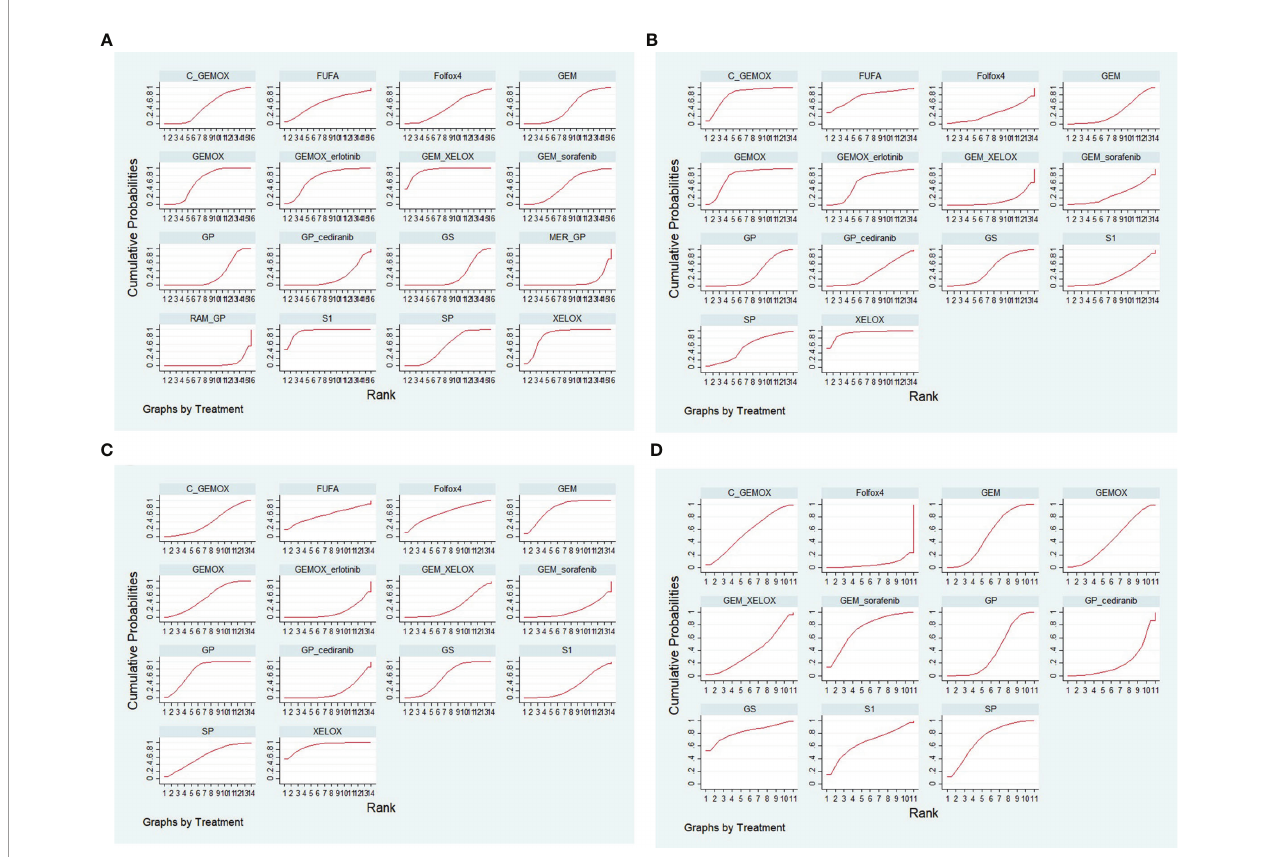
FIGURE 8 | The surface under the cumulative ranking (SUCRA) diagrams of adverse events (AEs) of each protocol: (A) neutropenia; (B) vomiting; (C) diarrhea; (D)